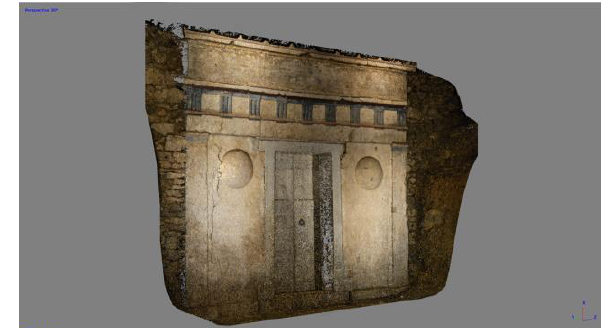
Figure 7. The Tomb of Philip II in Verghina. Cloud of points, detail from the west.